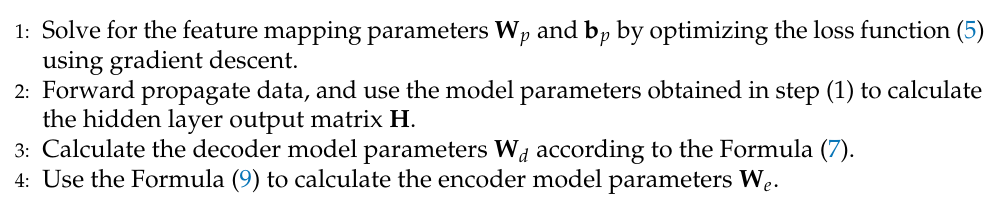
Algorithm 2 Forward training algorithm for autoencoders based on relative entropy con-